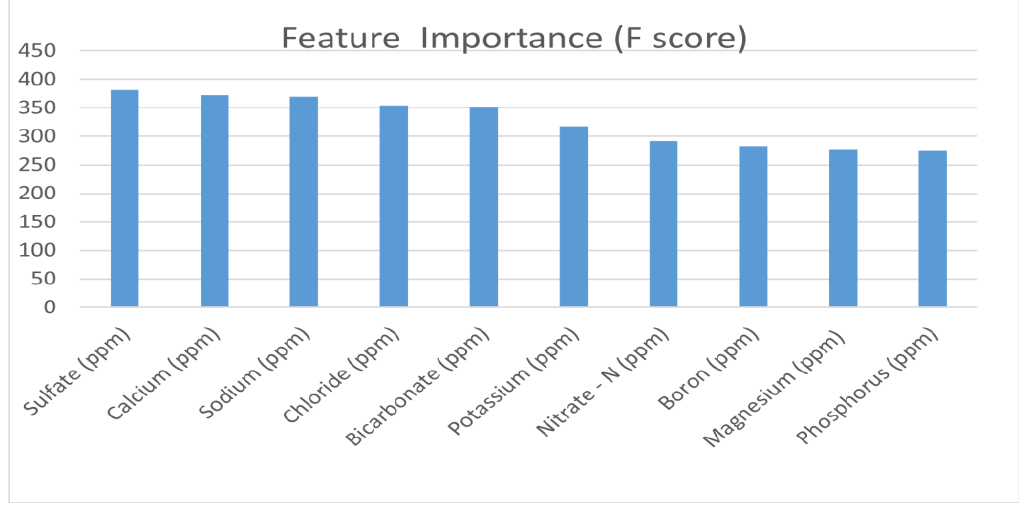
Figure 5. F-score of each predictor generated by the XGBoost algorithm.